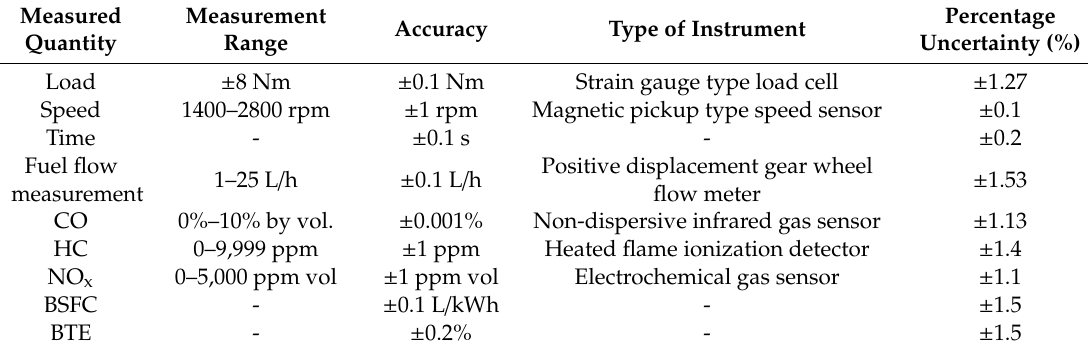
Table 2. The percentage of